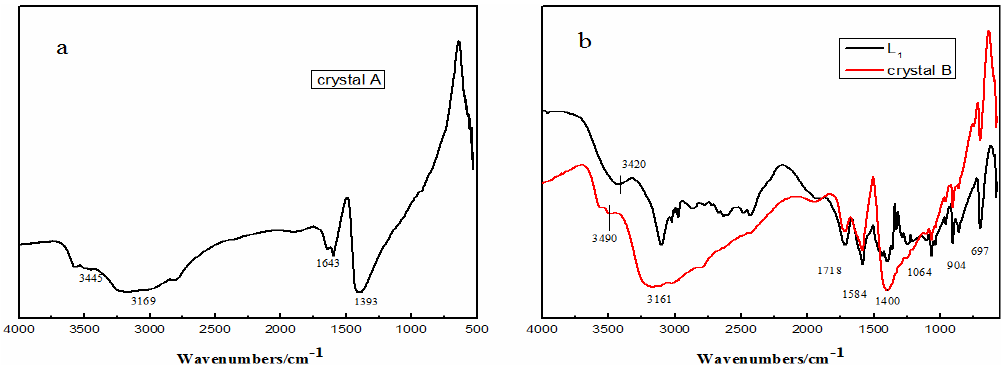
Figure 4. IR spectra of the crystal A ( a ), crystal B and L 1 ( b ).